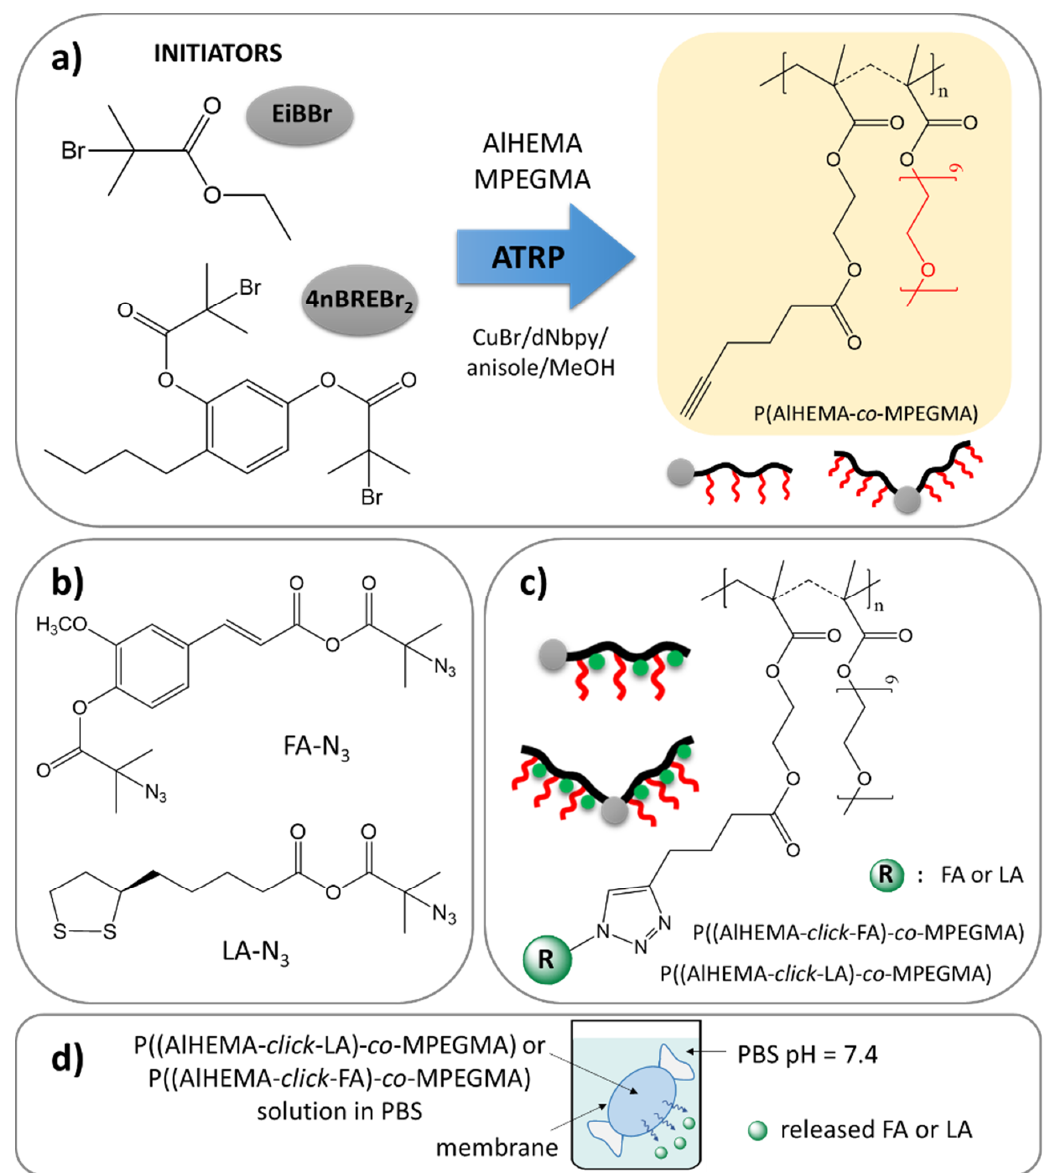
Figure 1. Synthetic route via copolymers obtained by ATRP ( a ), “click”-able antioxidants ( b ) to polymer-antioxidant conjugates ( c ), and their potential use as delivery systems ( d ).